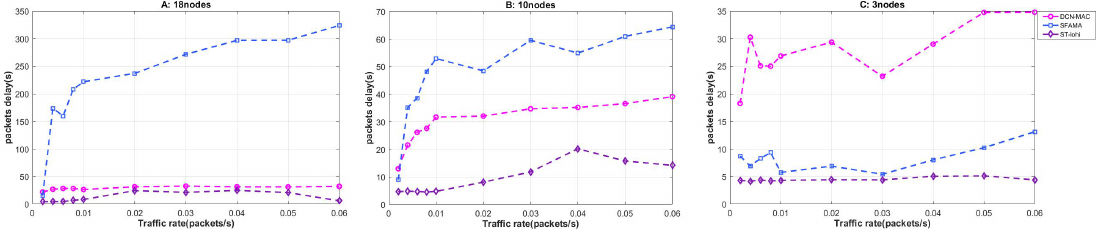
Figure 8. The packet delay of the network at different packet generation rates when the number of nodes was 3, 10, and